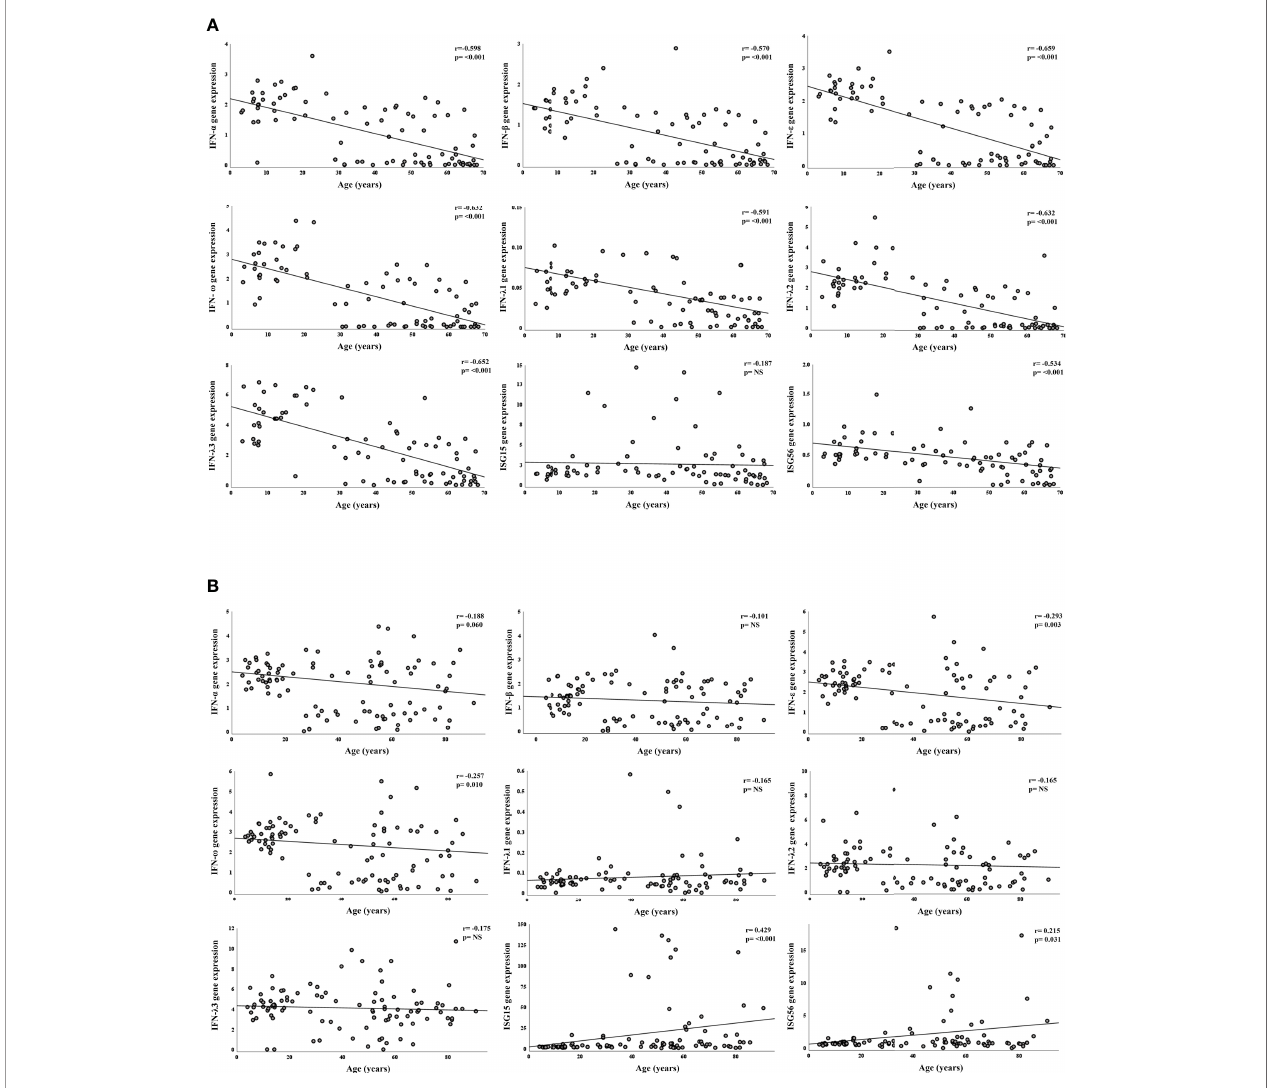
FIGURE 2 | Correlation between gene expression and age, in SARS-CoV-2 negative and positive subjects. Relative mRNA expression values (y-axis) are calculated using the threshold cycle relative quanti fi cation (2 - D Ct ); Spearman ’ s rho coef fi cient and p-values are reported in the upper right corner. Panel A : correlation of gene expression with age in years of SARS-CoV-2 negative subjects. Panel B : correlation of gene expression with age in years of SARS-CoV-2 positive